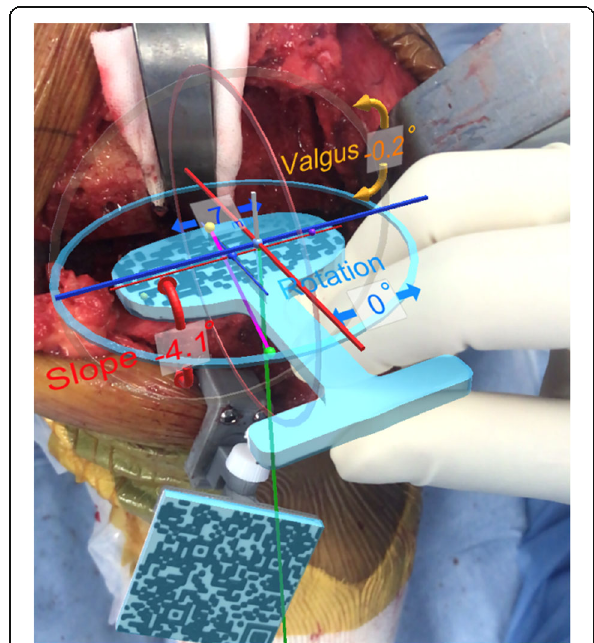
Fig. 4 Confirmation of the varus/valgus, posterior slope, and rotation angles after bone resection using the AR-KNEE system. The surgeon checked the angles of tibial resection by placing the oval guide (resin marker with oval two-dimensional bar code) on the resected bone surface. In this case, the AR-KNEE system showed a varus angle of 0.2°, posterior slope of 4.1°, and external rotation of